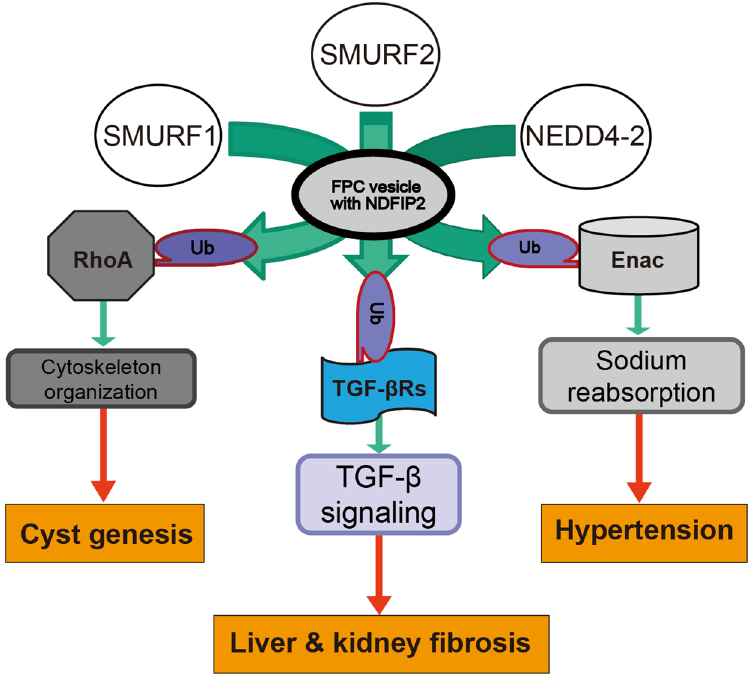
maintain balanced TGF- β signaling by regulating the targeting of SMURF1 and 2 to TGF- β receptors after ligand binding. FPC indirectly affects sodium balance by regulating the activity of NEDD4-2 in the CD and thereby affecting degradation of ENaC. These all functions are conducted through NDFIP2 in FPC positive